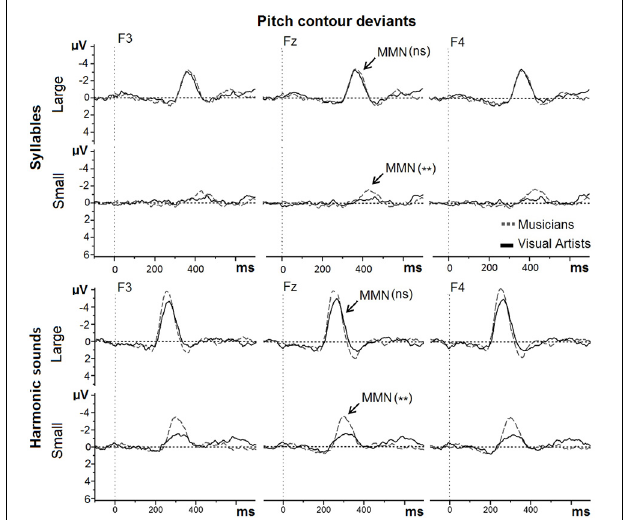
Pitch contour deviants FIGURE 3 | MMNs to Large and Small pitch contour deviants in